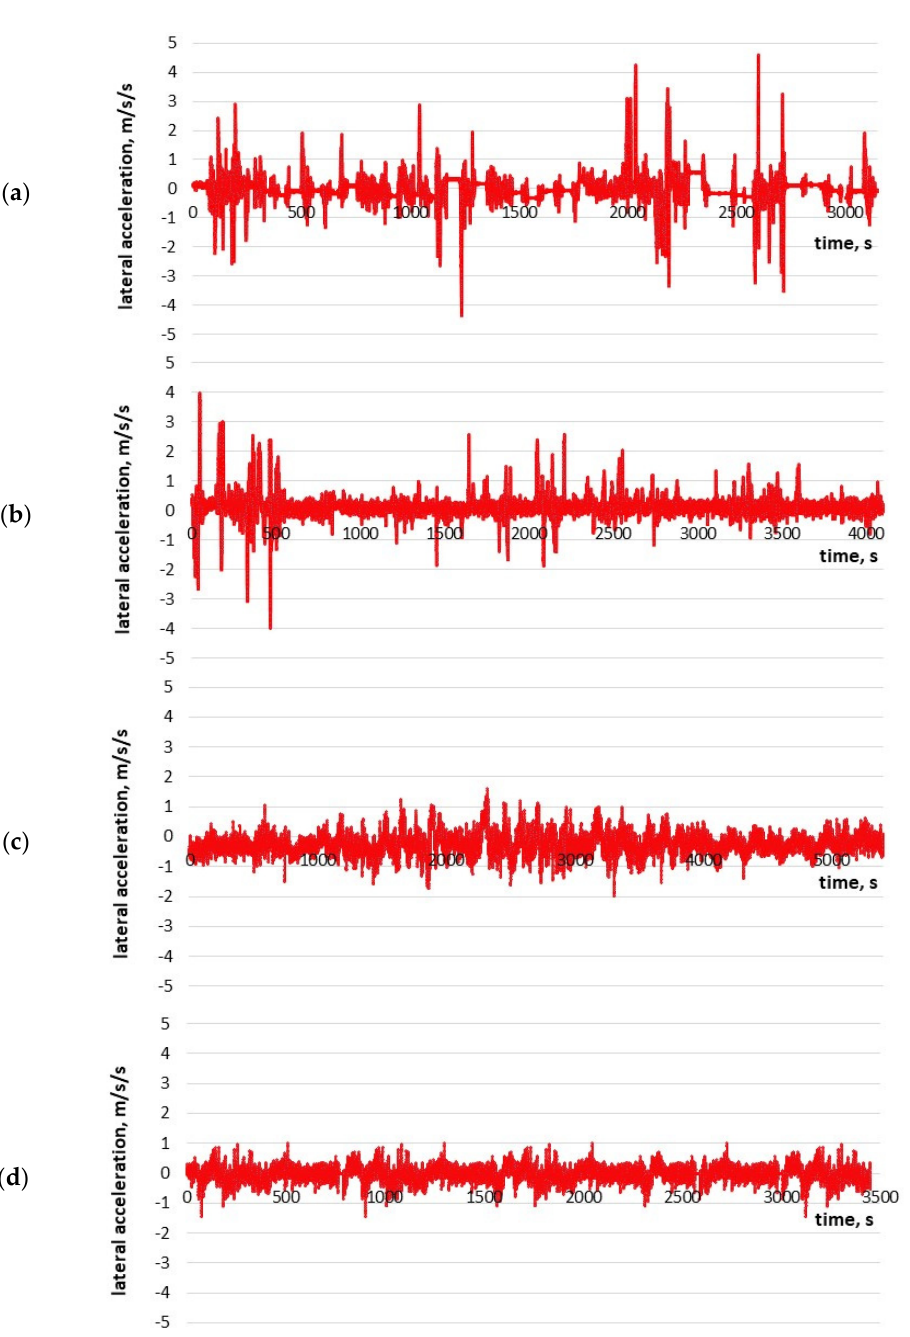
Figure 3. Values of longitudinal acceleration at specific sections on various road types: ( a ) urban area (city); ( b ) non-urban area (single roadway with two traffic lanes); ( c ) two-roadway express- way; ( d ) motorway.